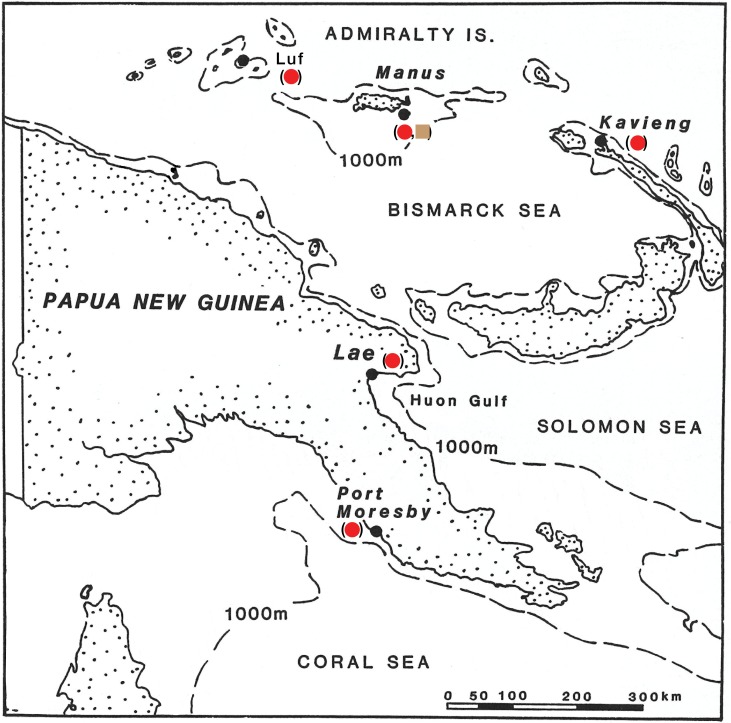
Details of Admiralty Is., PNG, showing trapped nautiloid locations and 1000-meter depth contours.Populations within 1,000 meter contours could have maintained gene flow. At depths >1000 meters, shell implosion would be an isolation factor. Modified from [28] with permission.